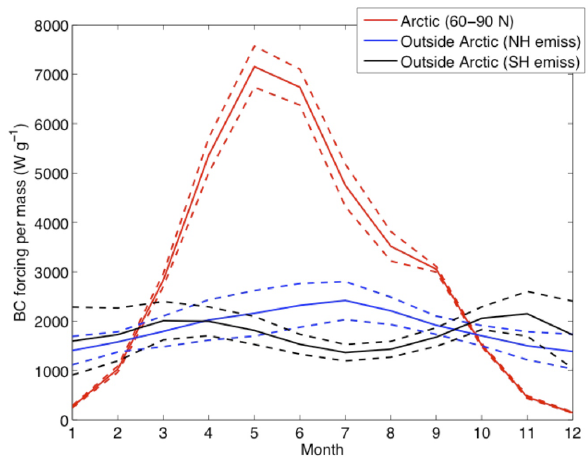
Fig. 5. Forcing-per-mass ( f S ) for black carbon in each month. Solid lines are global averages; dashed lines represent one standard devi- ation of the plotted regions. Arctic group (red) contains 23 regions and represents aerosol transported to the Arctic from all 23 regions. Other groups represent forcing-per-mass of all aerosol emitted from each region not located in the Arctic. NH outside Arctic (blue) con- tains 18 regions; SH outside Arctic (black) contains 5